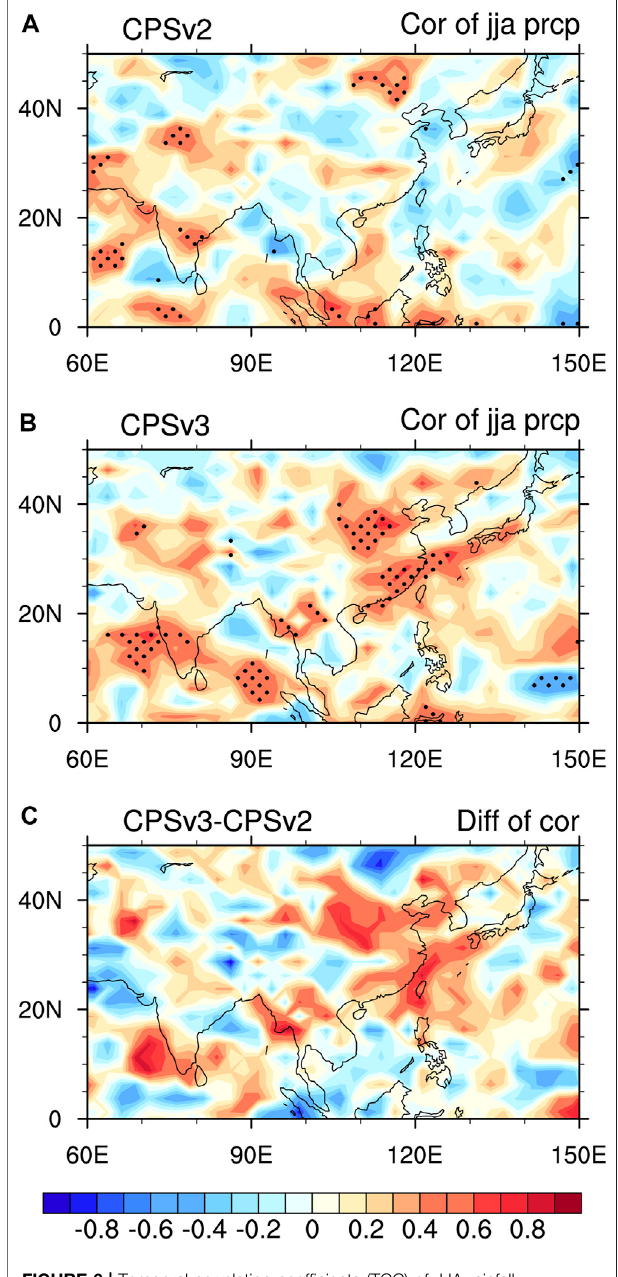
FIGURE 5 | Standard deviations of interannual variability of the JJA 500 hPa geopotential height (gpm) from (A) observation, (B) CPSv2 and (C) CPSv3 hindcasts, and (D) interannual variations of the WNPSH index (gpm).